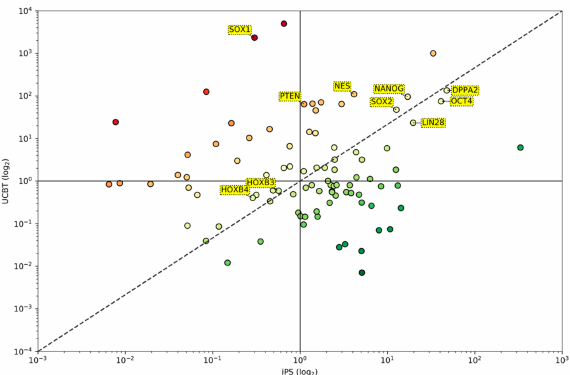
Figure 2. Log-log plot comparing the average expressions of genes in UCBT (y-axis) and iPS (x-axis). The dashed line represents the diagonal line (x = y), indicating equal average expression in UCBT and iPS. DPPA2, NANOG, LIN28, OCT4, SOX2, HOXB3, and HOXB4 are expressed at similar levels as they lie close to the diagonal. The expression of many other genes, such as PTEN, SOX1, and NES, are significantly different. The color gradient from red to green is used to indicate genes upregulated in UCBT (red) and genes upregulated in iPS. Table S1) recognizing proteins coded by DPPA2, LIN28, NANOG, NES, OCT4, PTEN, SOX1, SOX2, HOXB3, and HOXB4 in 69 samples analyzed by mRNA expression and in additional 44 samples with insufficient material for gene expression analysis. Figure 3 shows that the number of cells expressing the protein was always higher in adults after UCBT. In particular, for LIN28, OCT4, NESTIN, DPPA2, SOX1, and SOX2, no positive cells are detectable in UCB, whereas for adults after UCBT the percentage of positive cells ranges from 80% to 95%. Only for NANOG and PTEN, the percentage of positive cells was non-zero in UCB, being 40% and 80%, respectively. Nevertheless, the level of protein in single cells was always significantly lower in UCB (see median values and ranges reported for all proteins in Figure 3, panel b).